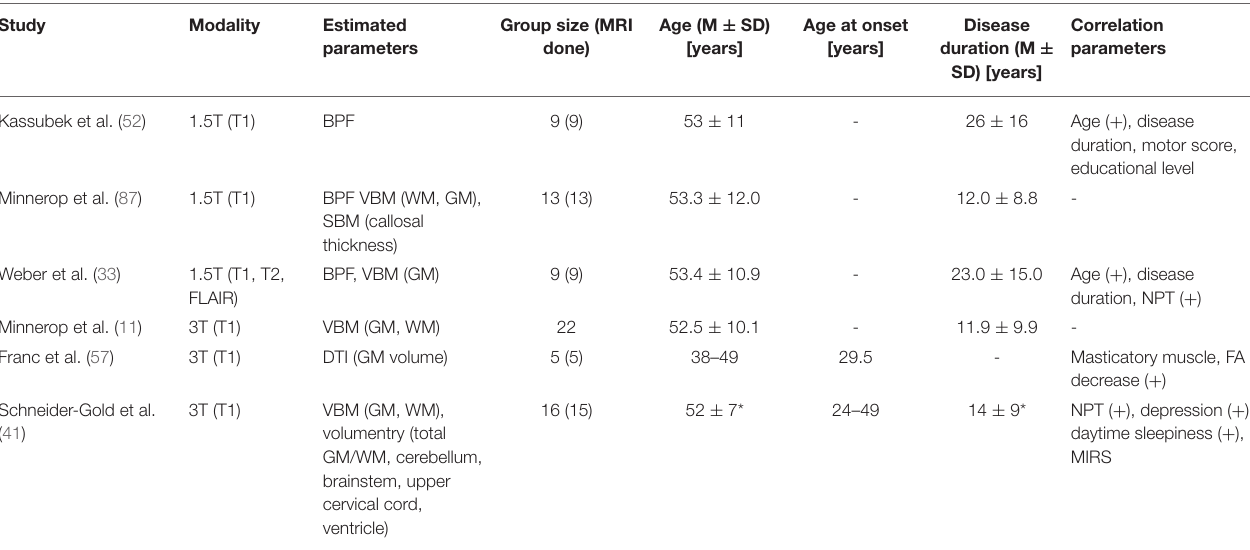
TABLE 6 | Quantification of brain volume in